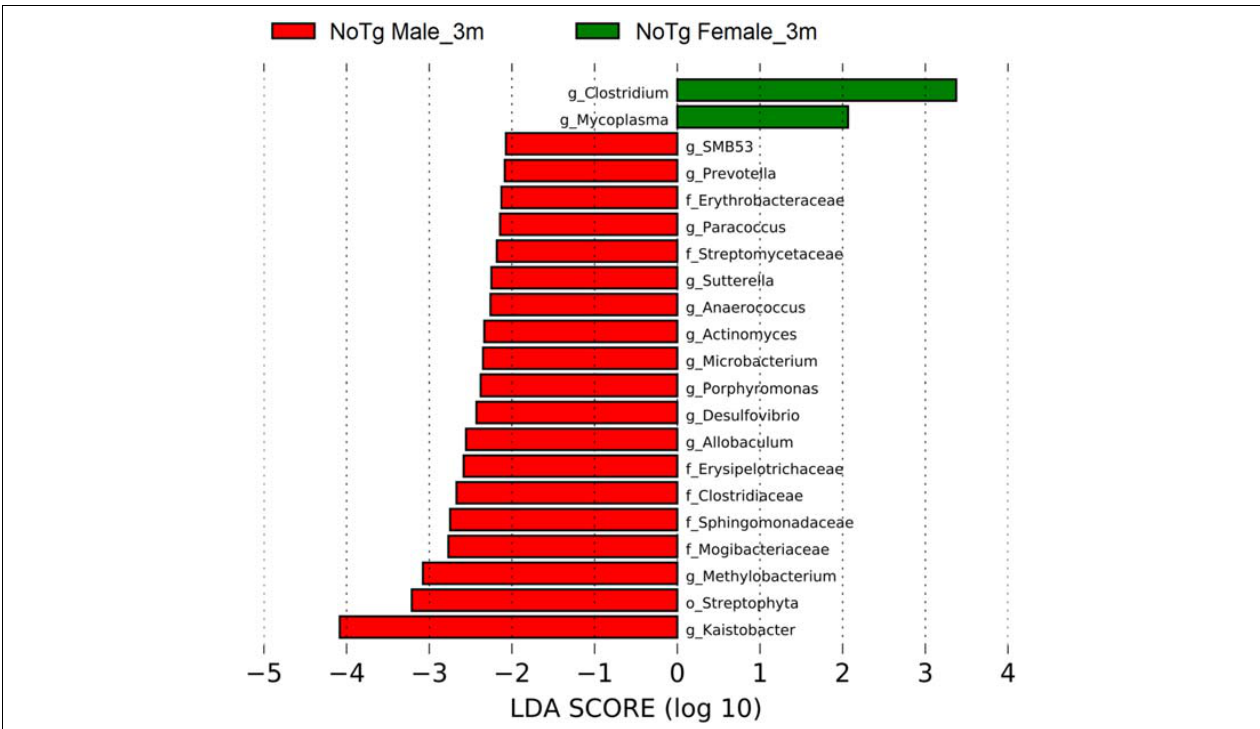
FIGURE 12 | Bacteria with statistically significant change on non-transgenic (NoTg) mice at 3 and 5 months (m) old for male and female in fecal samples. The bacteria with statistical relevance are shown by colors: red color indicates NoTg male at 3 months old; green, NoTg female at 3 months old. Horizontal bars represent the effect size for each taxon. The length of the bars represents the log 10 transformed linear discriminant analysis (LDA) score, indicated by vertical dotted lines. The threshold on the logarithmic LDA score for discriminative features was set to 2.0. The name of bacteria with a statistically significant change in the relative abundance is written alongside the horizontal lines. Taxa names are abbreviated as “c,” class; “o,” order; “f,” family, and “g,” genus. See Supplementary Table 6 for full taxon description and LDA score and p